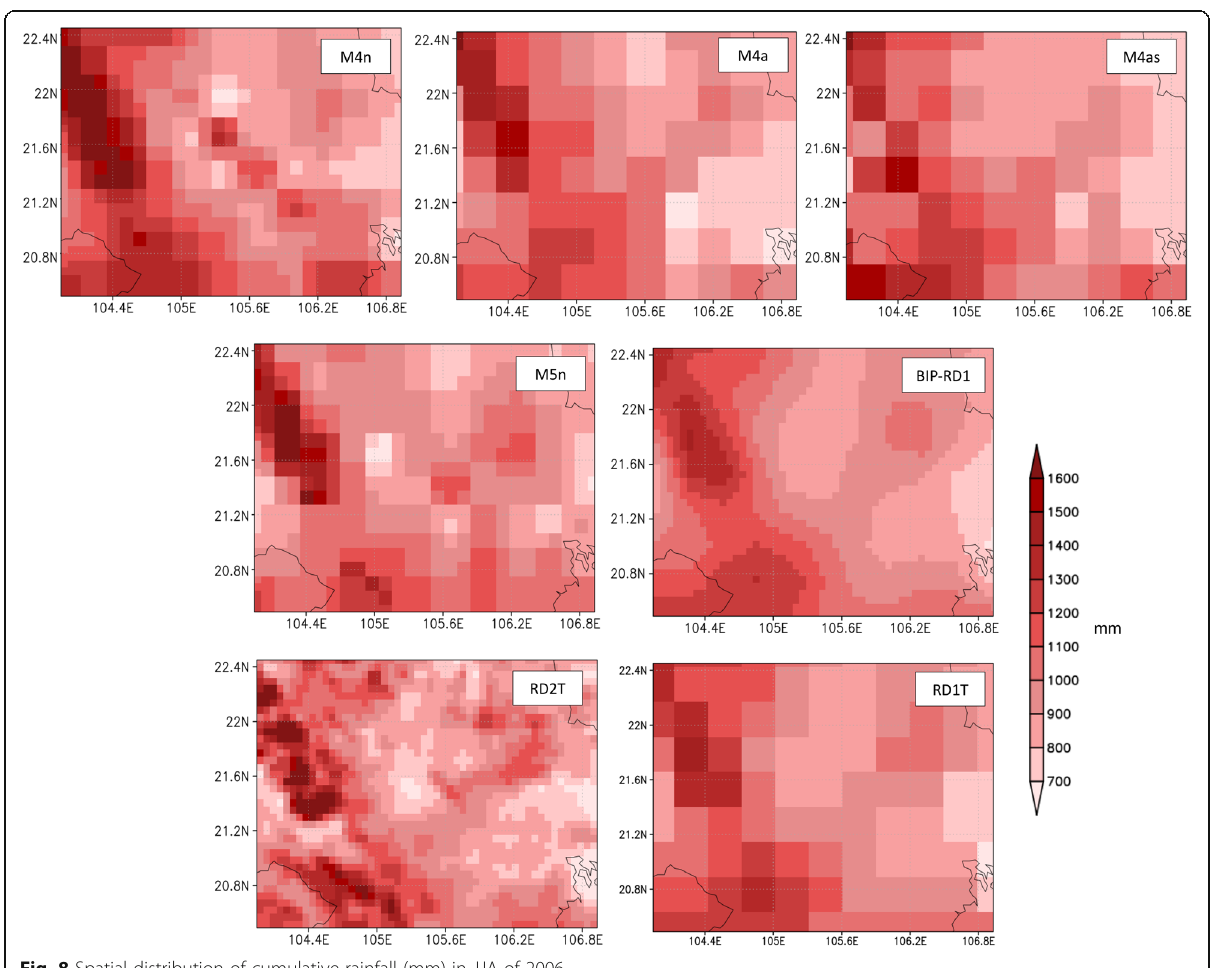
Fig. 8 Spatial distribution of cumulative rainfall (mm) in JJA of